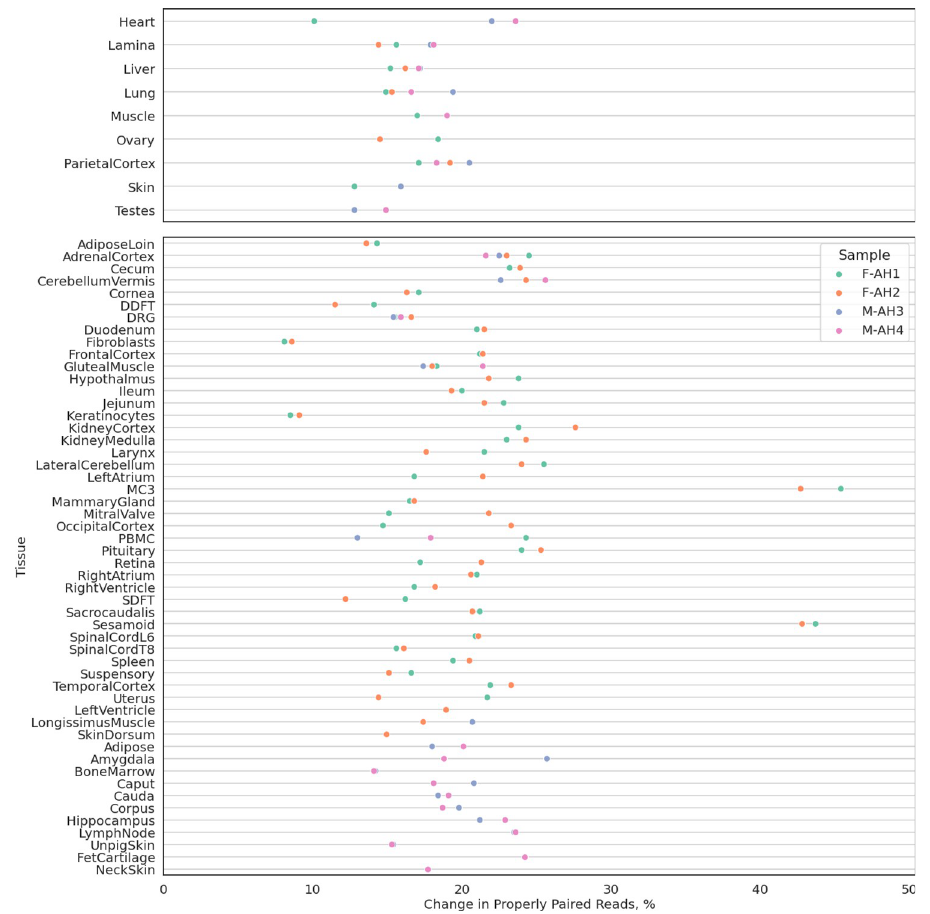
Fig 2. Comparison of FAANG, RefSeq and Ensembl equine transcriptomes. Changes in percentages of properly paired reads aligned to combined FAANG transcriptome when compared to Ensembl or RefSeq transcriptomes, whichever has higher